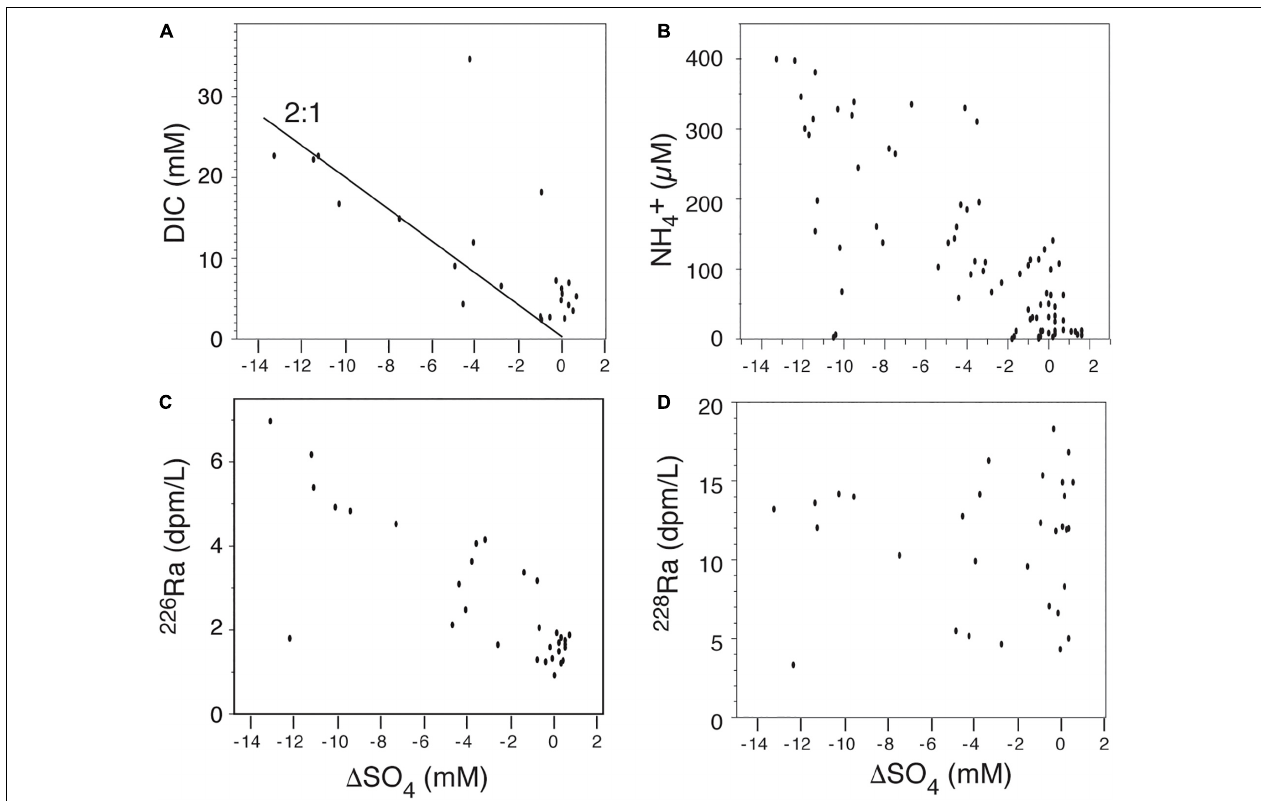
FIGURE 3 | Data from the Okatee subterranean estuary, South Carolina, showing the relationship between sulfate depletion by C oxidation (see text) and dissolved species. (A) The concentration of dissolved CO 2 increases with a 2:1 ratio as sulfate is depleted (Eq. 2). (B) The concentration of dissolved NH 4 + reaches 400 µ M in samples with the greatest sulfate depletion. (C) Dissolved 226 Ra increases with increased sulfate depletion, implying organic matter degradation either directly or due to secondary reactions releases significant 226 Ra. (D) Dissolved 228 Ra shows an irregular pattern with high activities occurring at high and low sulfate depletion, implying that desorption of 228 Ra regenerated from 232 Th decay governs its behavior. Data from Moore et al. (2006) and Porubsky et al.